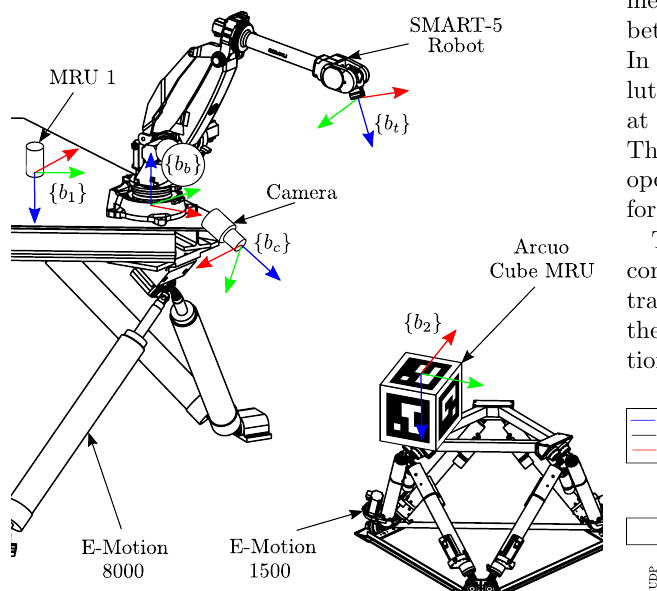
Figure 2: The Norwegian Motion Laboratory located at the University of Agder.